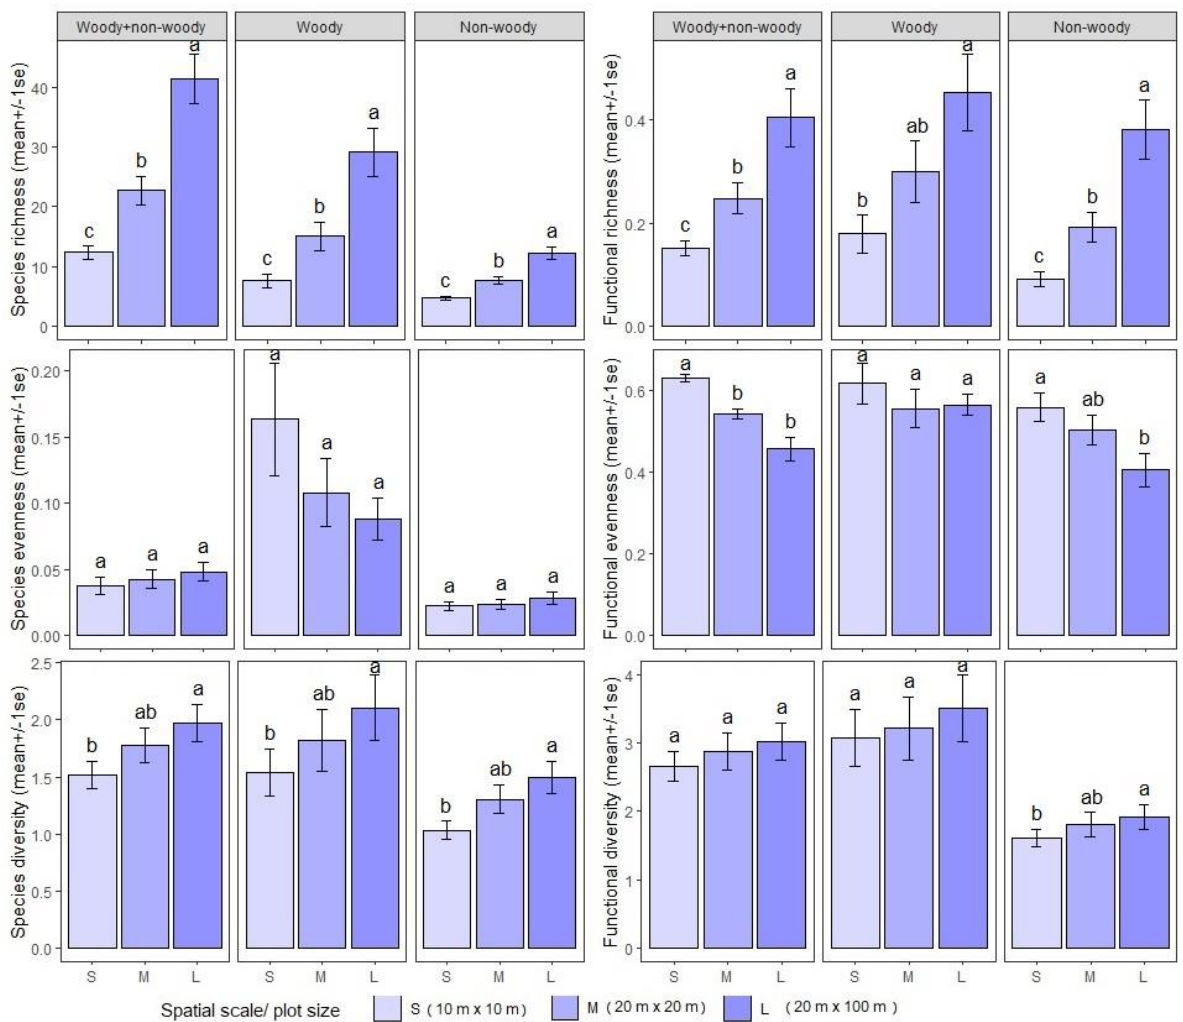
Figure 4. Variations in the mean values ( ± 1se) of different facets of species and functional diversity concerning spatial scale (L = large scale, M = medium scale and S = small scale) and vegetation layers. Bars marked with the same letters do not differ significantly at α = 0.05, as identified by Tukey’s post-hoc test.